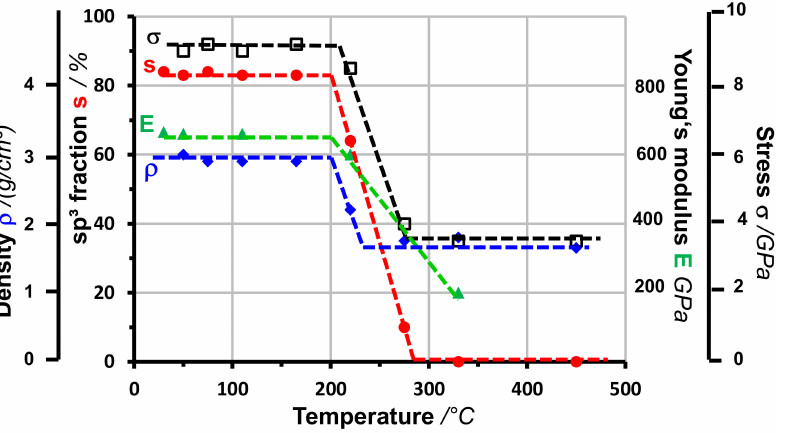
Figure 18. Dependence of structural and mechanical properties on the substrate temperature for carbon films prepared by vacuum arc deposition. Filtered dc arc deposition with ion energies of 90 eV. Data from